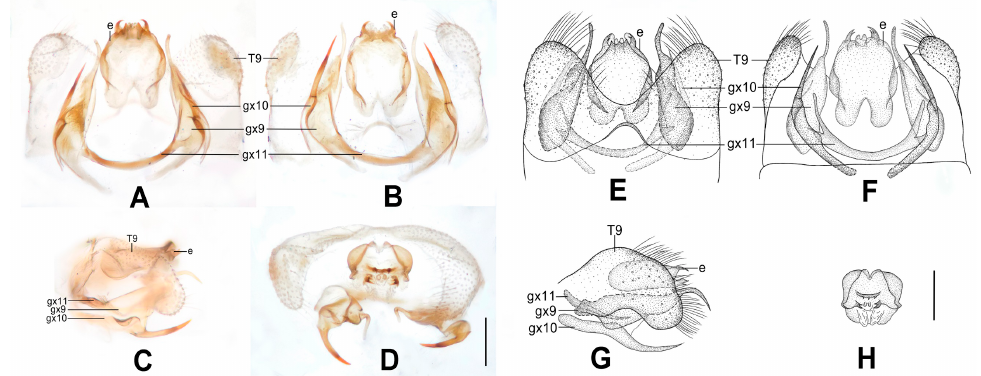
Figure 8. Dilar malickyi sp. nov. ( A – D ) male holotype, genitalia, photographs: ( A ) dorsal view; ( B ) ventral view; ( C ) lateral view; ( D ) caudal view. ( E – H ) male holotype, genitalia, line drawings: ( E ) dorsal view; ( F ) ventral view; ( G ) lateral view; ( H ) ectoproct, caudal view. e: ectoproct; gx9: gonocoxite 9; gx10: gonocoxite 10; gx11: fused gonocoxites 11; T9: tergum 9. Scale bars: 0.2 mm. Diagnosis. The new species is characterized by the sparsely spotted pale brown forewing, the male ectoproct posterodorsally with three pointed processes of same length, the male gonocoxite 9 with narrowly elongate tip, and the fused male gonocoxites 11 obviously bifurcated at both ends.